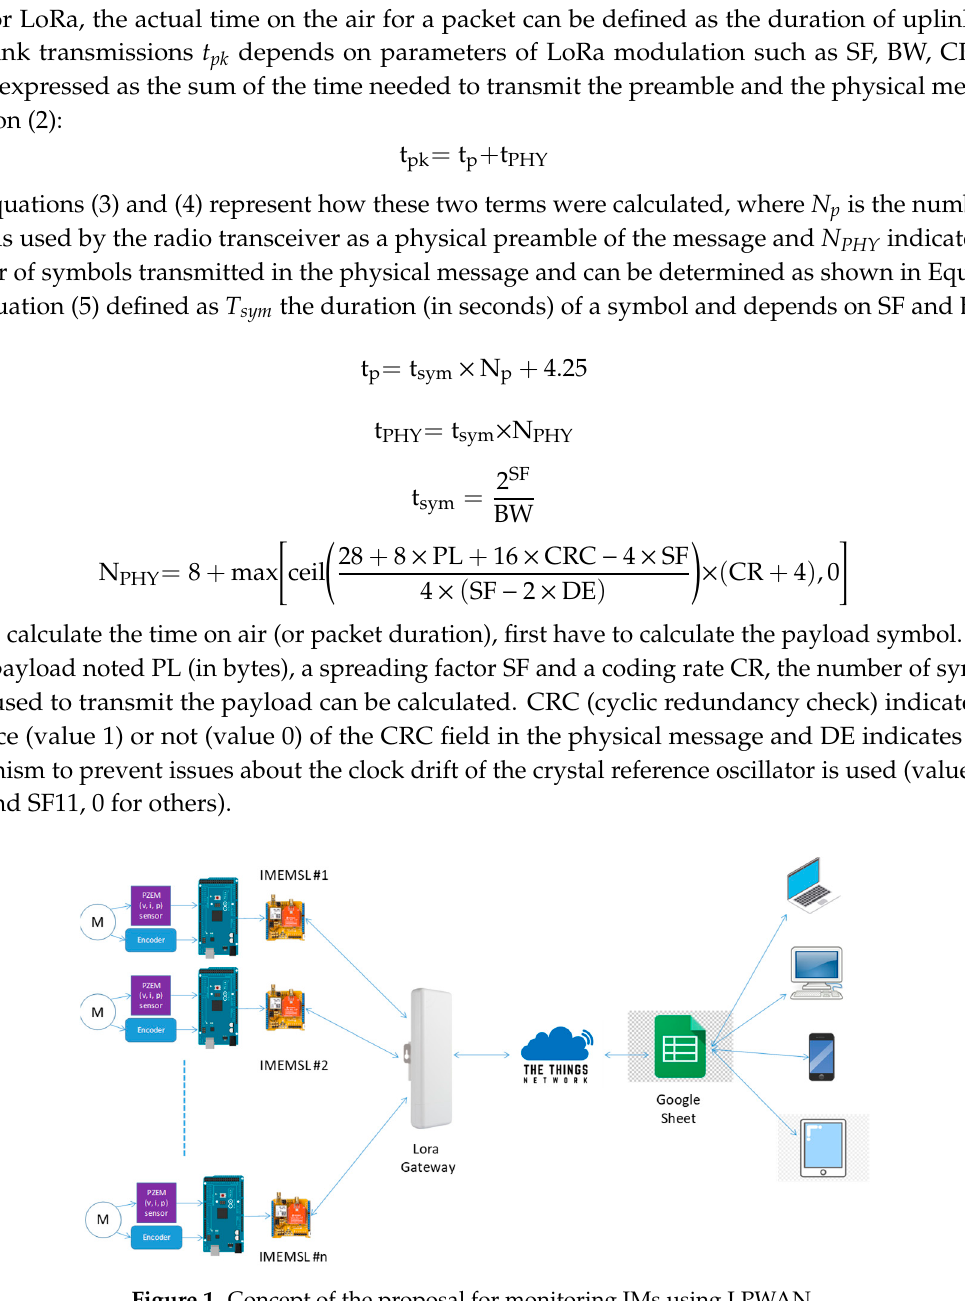
Figure 1. Concept of the proposal for monitoring IMs using LPWAN.